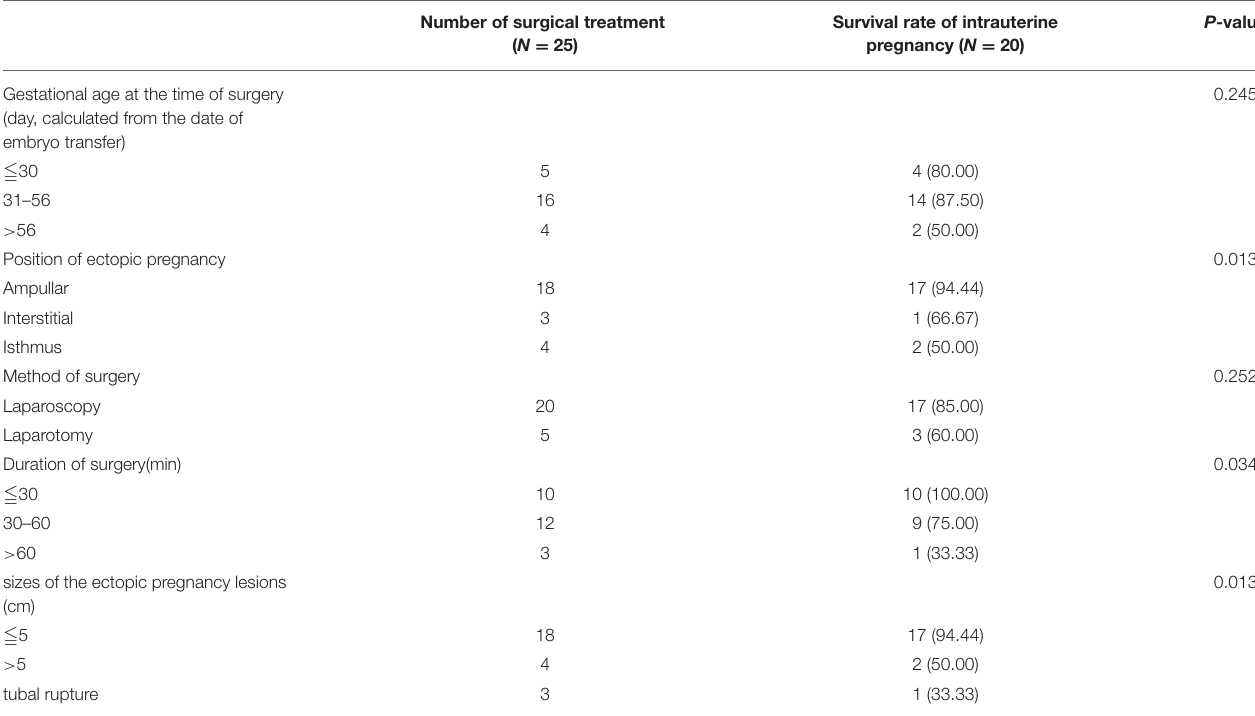
TABLE 4 | Influence of surgical characteristics on survival of intrauterine pregnancy following surgical treatment of HP.